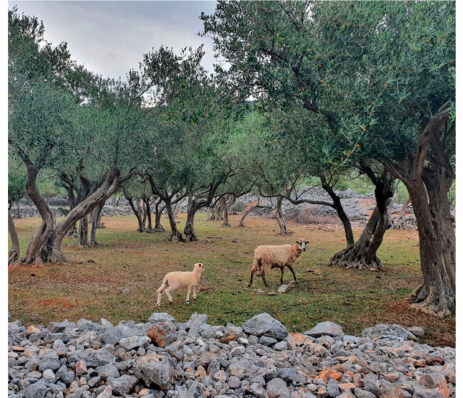
Figure 10. A common sight within the Cres olive grove: the dry stone wall-olive-sheep association (Tanja Kremeni´c,